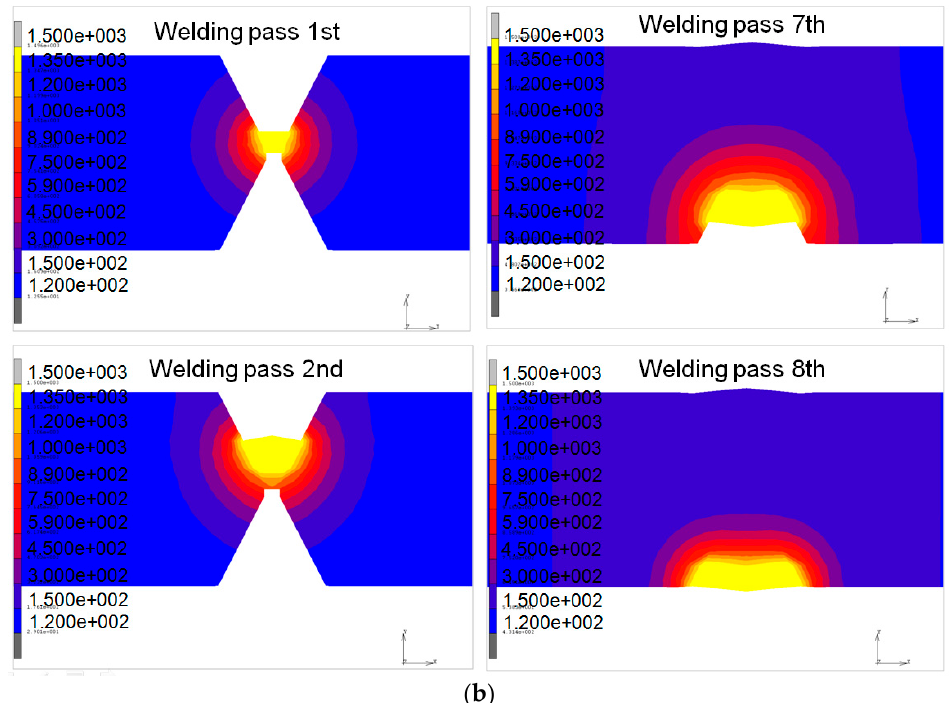
Figure 9. ( a ) Heat distribution (temperature) of the FEM analysis results of NGW. ( b ) Heat distribution (temperature) of the FEM analysis results of X-groove.